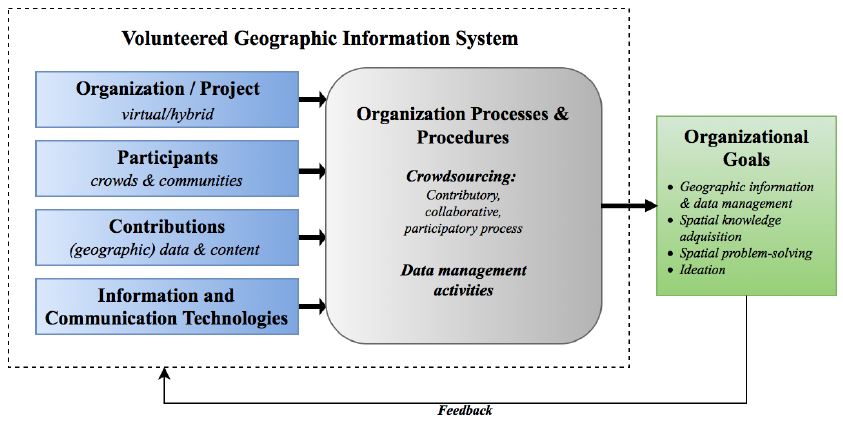
Figure 1. A General VGI (Volunteered Geographic Information) System.